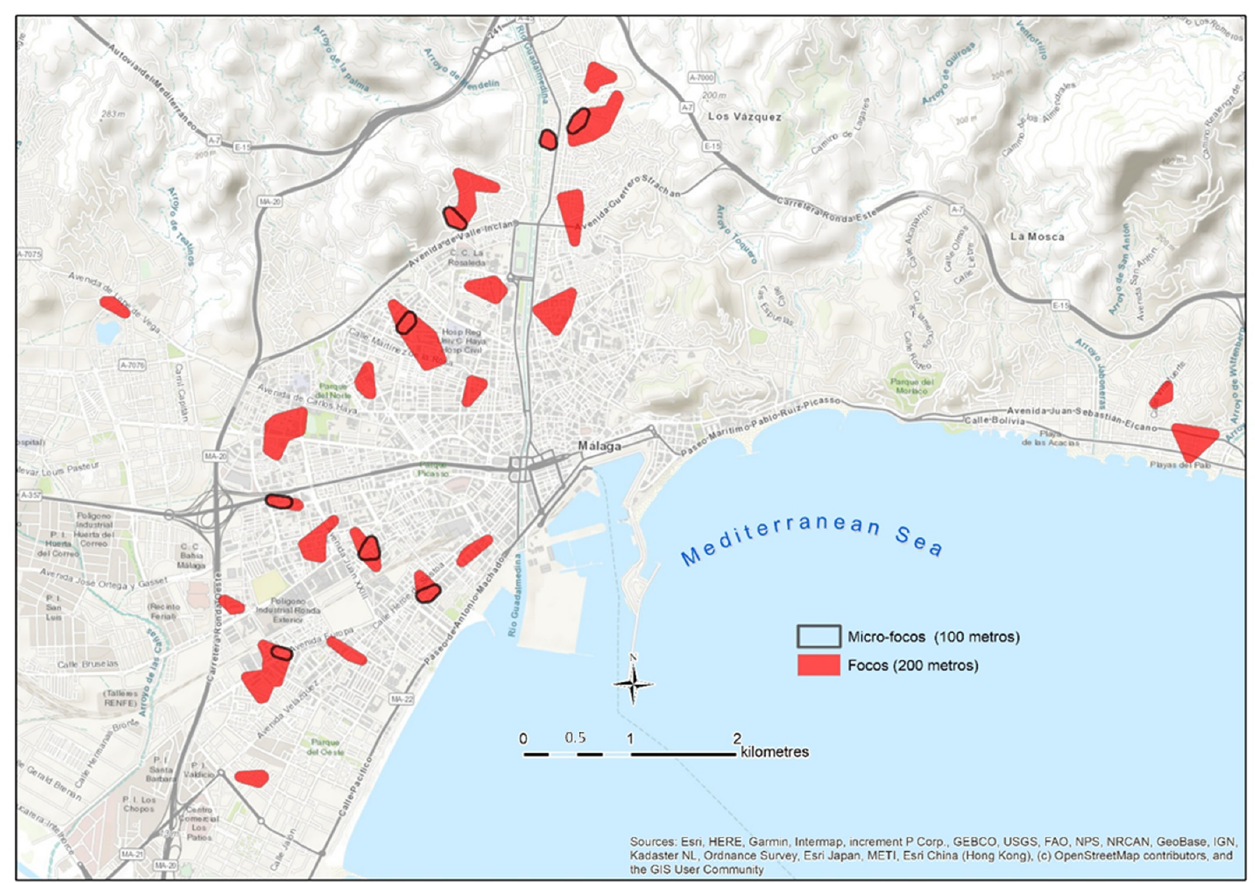
Figure 7. Distribution map of the contagion focuses in the first half of August. Table 5 shows the parameters of the epidemic in the sectors where the focus have been delimited compared to areas in which the contagion pattern is dispersed. As it can be seen, the values in both areas are significantly different. Table 5. Data of the incidence of the epidemic inside/outside the contagion focuses.